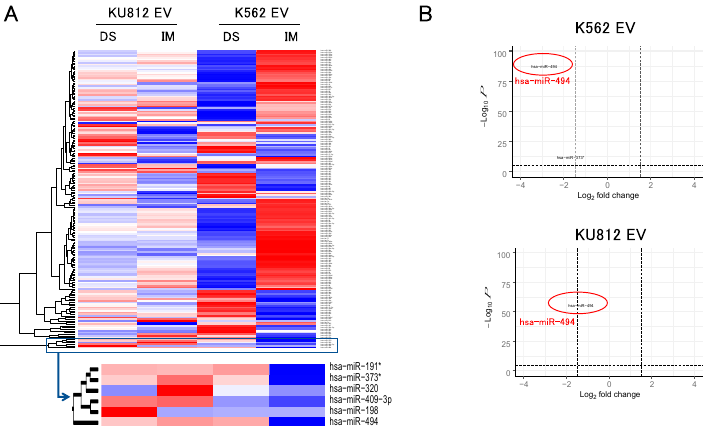
Figure 2. MiRNA microarray analysis in EV from two cell lines. ( A ) Heatmap and hierarchical clustering after TKIs treatments. Red or blue color indicate increased or decreased miRNA in EVs after TKIs treatment, respectively. Six miRNAs were clustered as the independent group. (IM: imatinib, DS: dasatinib) ( B ) Volcano plots from miRNA microarray analysis of two cell lines. For drawing volcano plots, the integrated data from both TKIs was used to detect commonly fluctuating